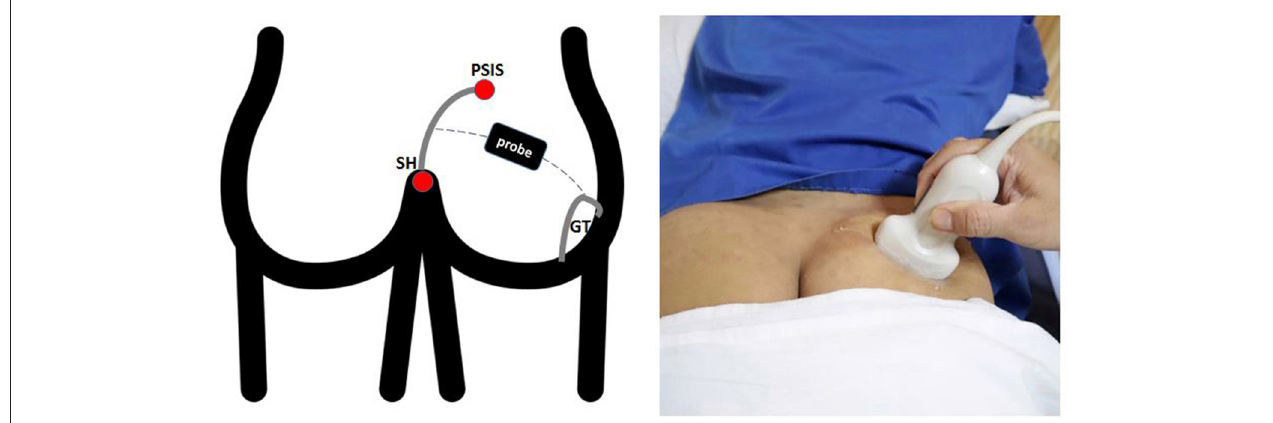
FIGURE 1 | Surface landmarks. The lateral border of the sacrum was define by the line between the PSIS and the SH. The superficial line connecting the midpoint of the sacral border and the upper border of the GT runs approximately parallel to the piriformis muscle. PSIS, Posterior Superior Iliac Spine; SH, Sacral Hiatus; GT, Greater Trochanter.